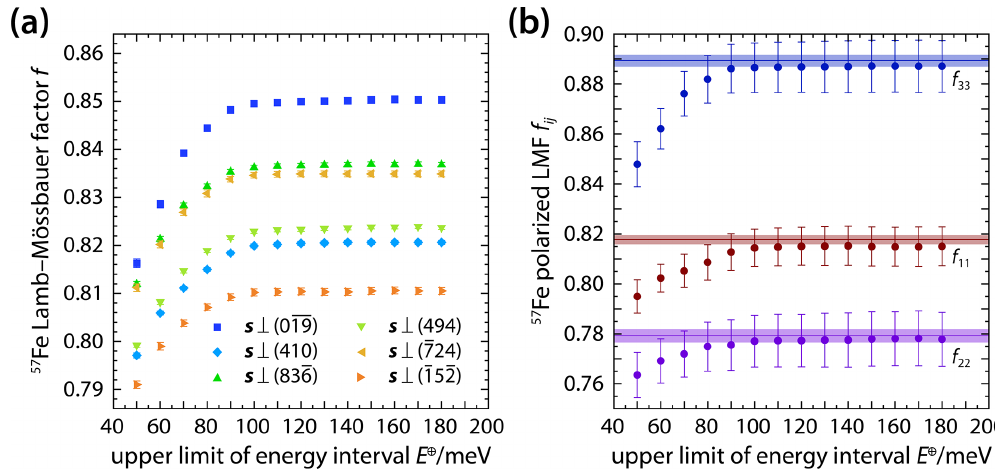
Figure 4. Lamb–Mössbauer factors of 57 Fe atoms in δ -(Al,Fe)OOH single crystals. Lamb–Mössbauer factors (a) were derived from NRIXS spectra recorded with the X-ray beam incident along different directions s and by stepwise increasing the analyzed energy interval. The anisotropy of the Lamb–Mössbauer factor (LMF) can be described using a second-rank tensor with the components f 11 , f 22 , and f 33 (b) that can be obtained by inverting (solid circles) the observed Lamb–Mössbauer factors (shown in a ) or by integrating (horizontal lines) the components of the polarized PDOS (Fig. 2b). Shaded areas indicate